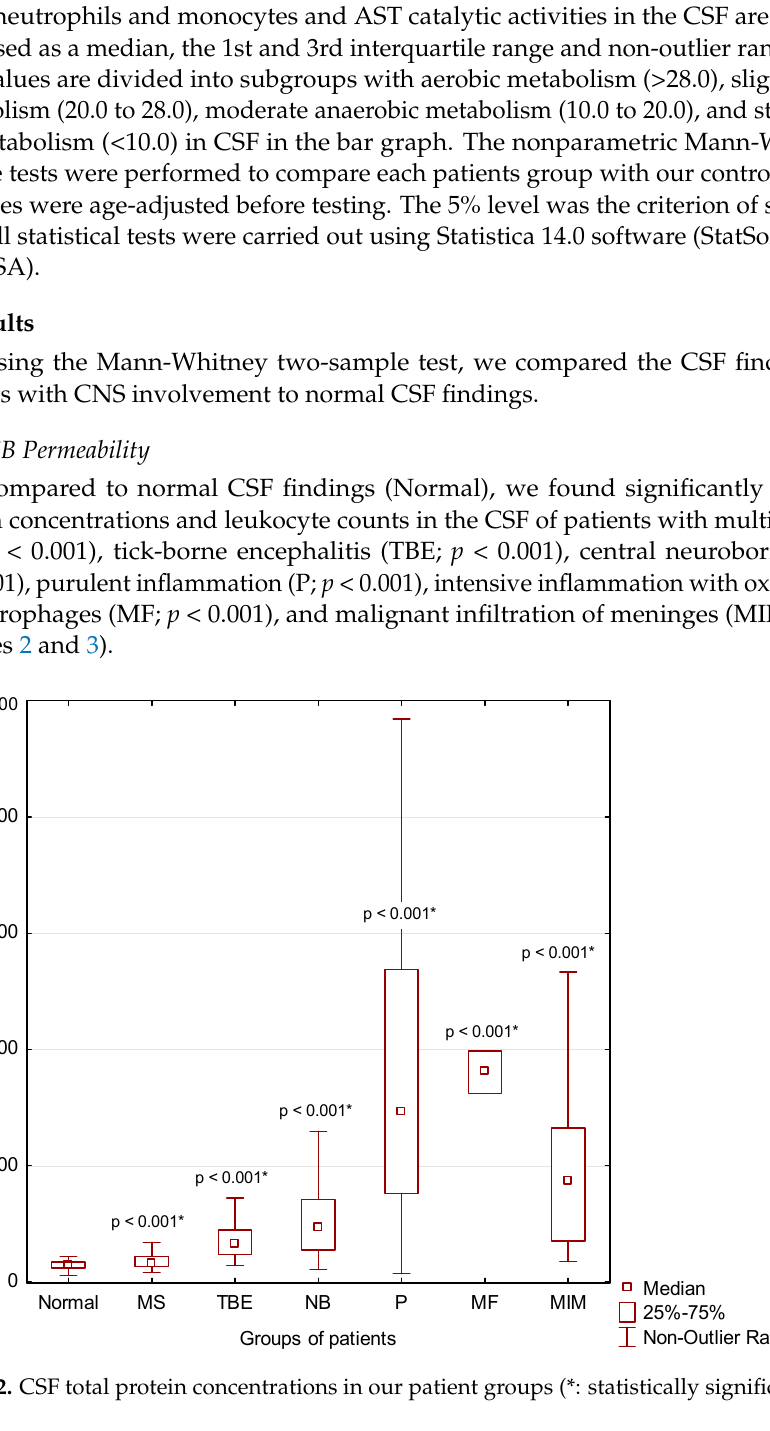
Figure 3. CSF leukocyte counts in our patient groups (*: statistically significant).